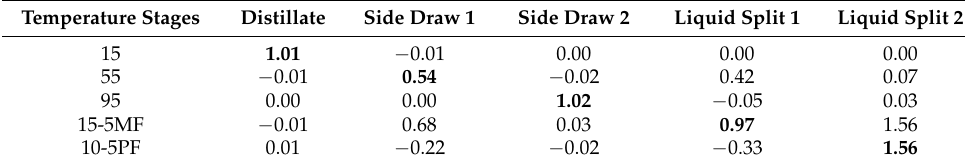
Table 5. RGA analysis for mixture 2.